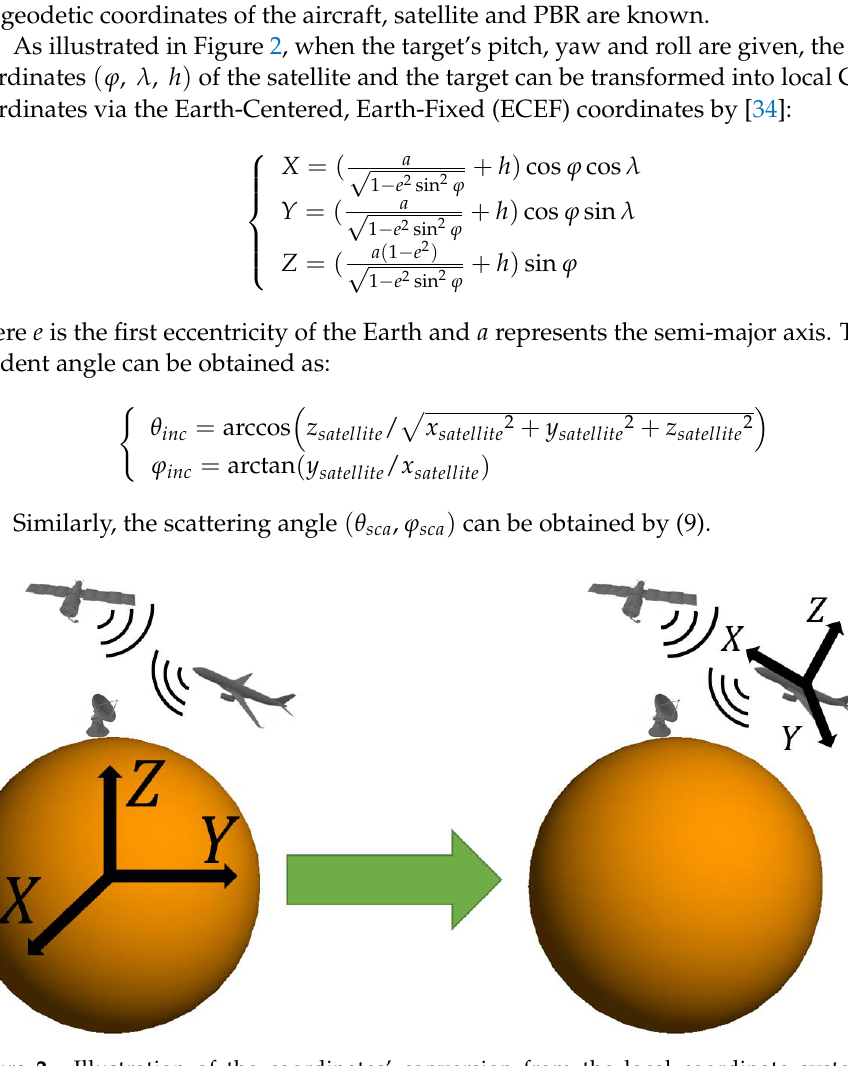
Figure 2. Illustration of the coordinates ’ conversion from the local coordinate system to the ECEF coordinates. ECEF